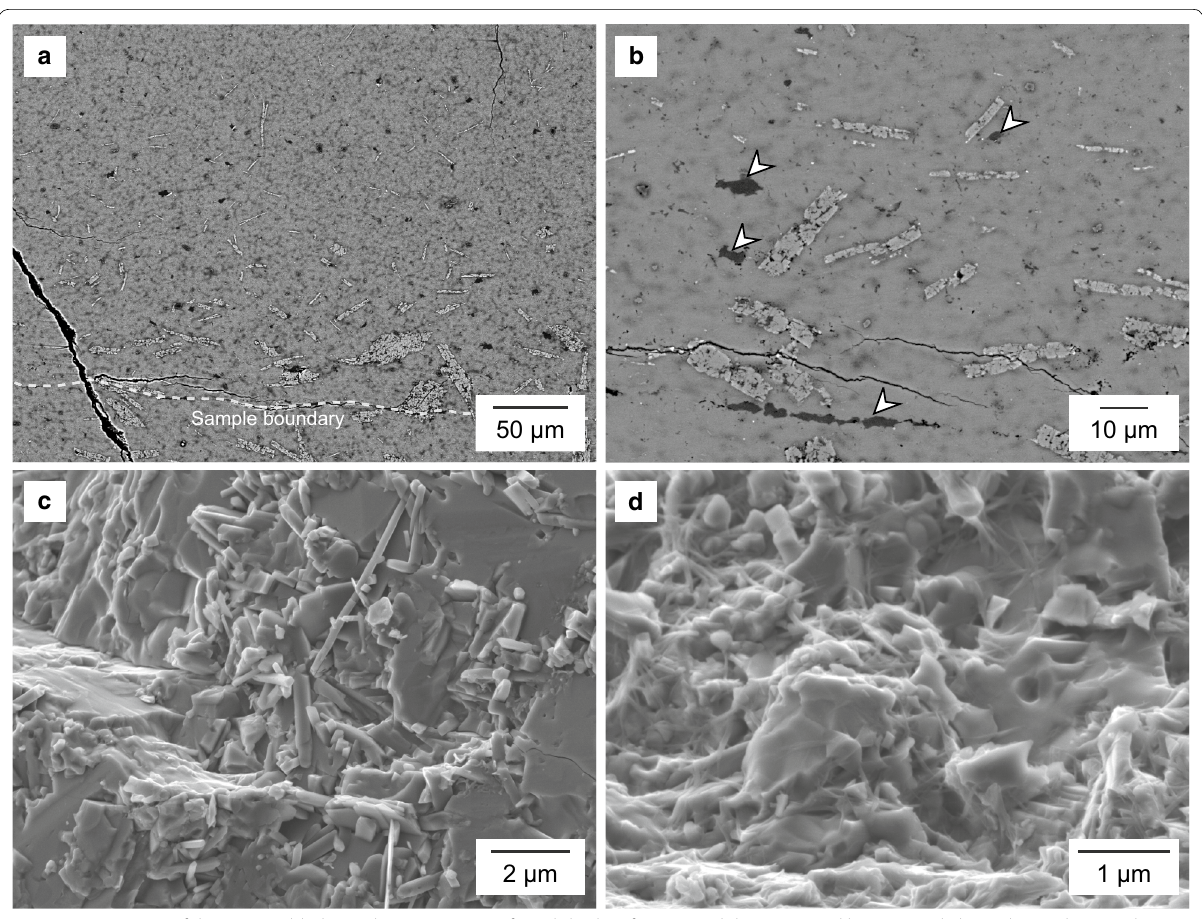
Fig. 6 SEM images of the water‑added sample. a BSE image of a polished surface around the upper and lower sample boundaries. The sample boundary is shown as a white dashed line. The grains with a light gray color, a length of ~ 50 μm, and an aspect ratio of ~ 5 are zoisite, which is seen especially around the sample boundaries. b Enlarged image of the thin section. Large SiO 2 materials are shown in dark gray with arrows. They are sometimes segregated, but they are also seen around grain contacts (slightly darker colors), similar to the initial sample (Fig. 1). A reduction of pores is observed, especially around the bulging and transparent portions (see Fig. 5). c , d Secondary electron images of broken surfaces within approxi‑ mately 200 μm of the sample boundary. Highly elongated grains (lengths of ~ 5 μm and aspect ratios of ~ 5) are developed on the anorthite grains. Vermicular‑like features can also be observed in ( d